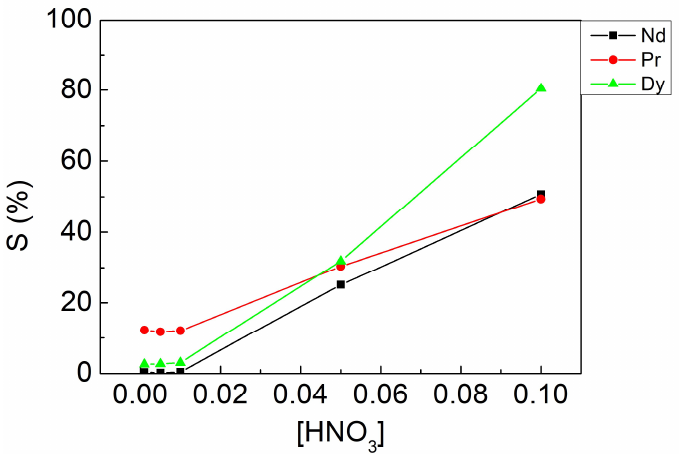
Figure 6. Stripping efficiencies at different nitric acid concentrations. Fixed parameters: A/O ratio of 1, contacting time of 10